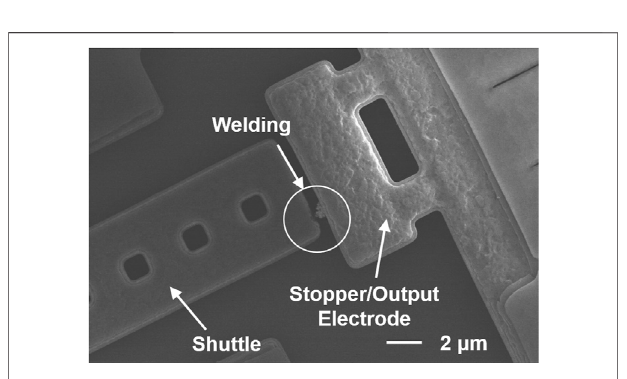
FIGURE 4 | SEM image of a resoswitch with a shuttle welded with the output electrode. Reproduced from Liao (2019).